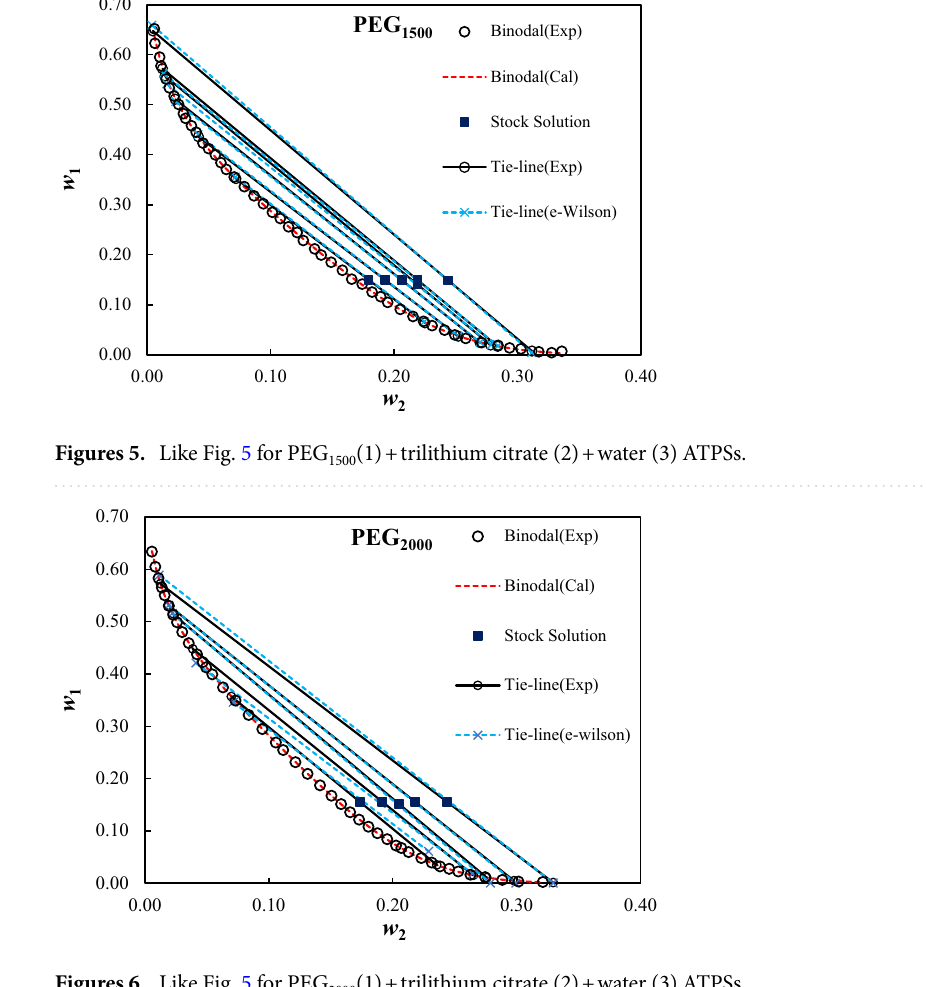
Figures 6. Like Fig. 5 for PEG 2000 (1) + trilithium citrate (2) + water (3)